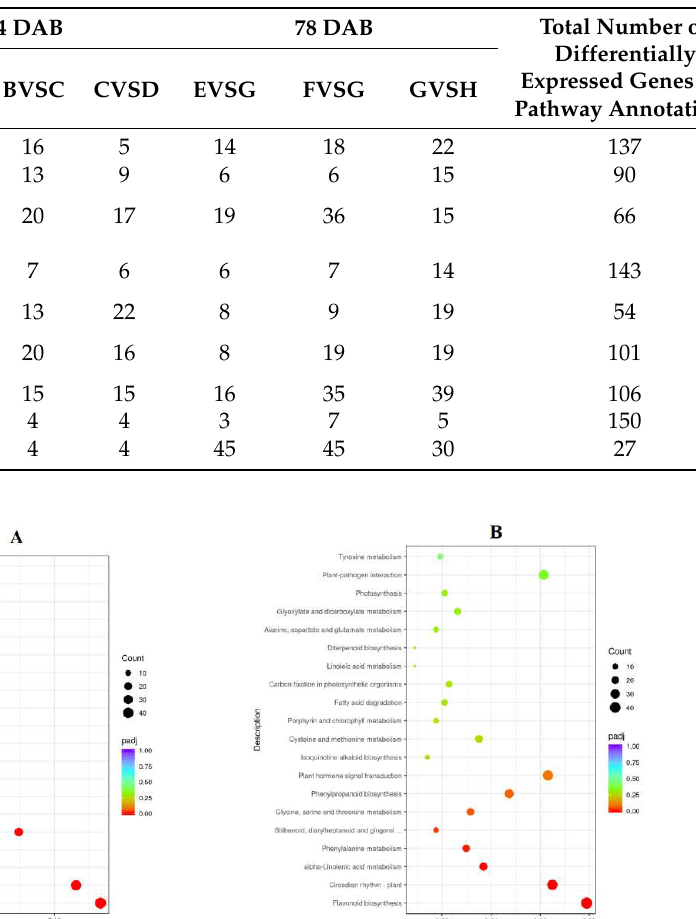
Table 6. Overview of KEGG analysis of differentially expressed genes.